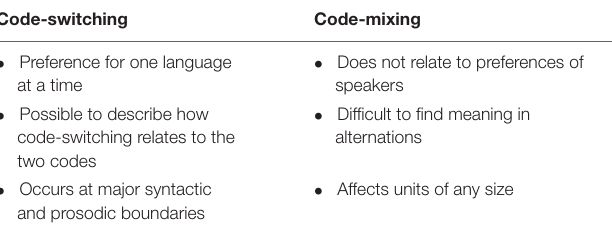
TABLE 4 | Basic criteria for distinguishing code-switching from code-mixing (Auer,